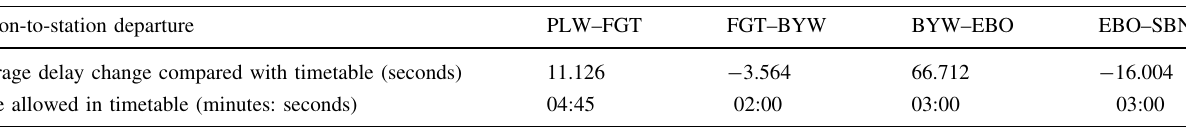
Table 2 PLW–SBN, table showing average delay change from PLW to SBN and time allowed in the timetable to travel between each station Station-to-station